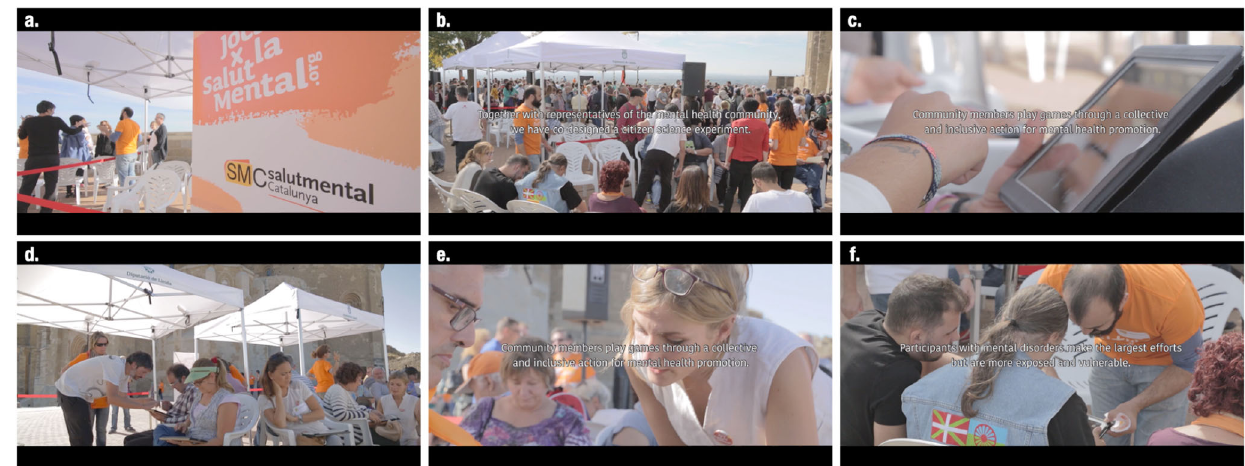
Fig. 3 Frames extracted from the video “ Games for Mental Health ” recorded on 8th of October 2016. a Aspect of the space before starting the experience. b Broad view of the experience and participants within the context of the World Mental Health Day event. c Interactions within games were facilitated by means of a digital interface on electronic tablets. d Group of six participants before starting a session with a set of games. e and f Personalised support for participants, in case they did not understand the rules of any of the set of